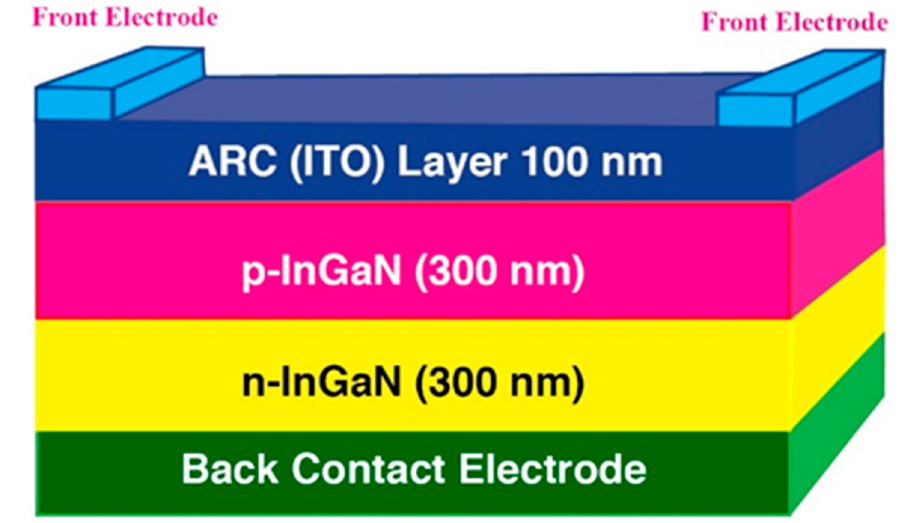
Figure 1. Structural diagram of an InGaN solar cell. Table 1. Calibrated InGaN structure of material